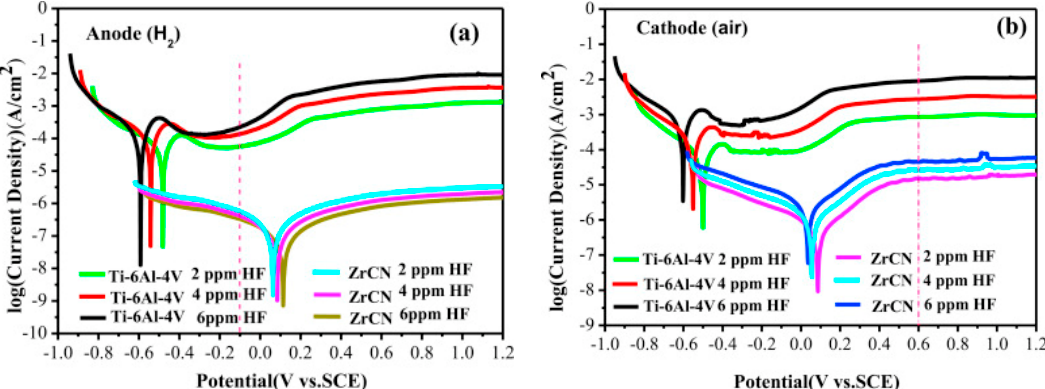
Figure 15. Influence of fluoride addition on corrosion behavior of Ti-Al6-V4 alloy and ZrCN coating. Reprinted from [66] copyright (2015), with permission from